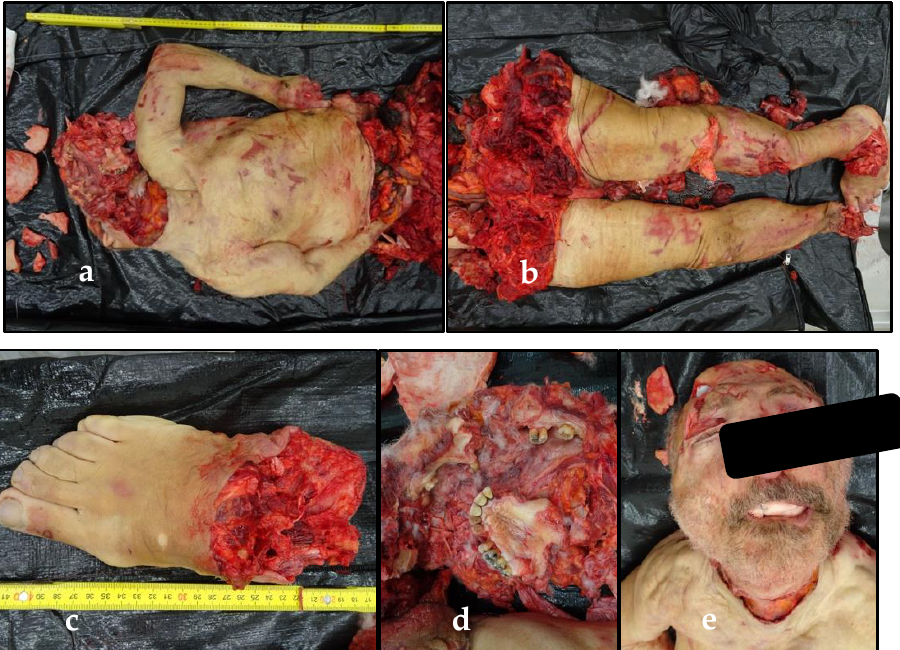
Figure 2. The widespread depletion of the corpse: ( a ) the neck, the trunk, and the arms; ( b ) the pelvis and the lower limbs; ( c ) the right foot; ( d ) some neurocranium and face ’ s soft tissues pieces, and some dental elements; ( e ) the victim ’ s face, whose soft tissues were reassembled and supported by packing a puppet.